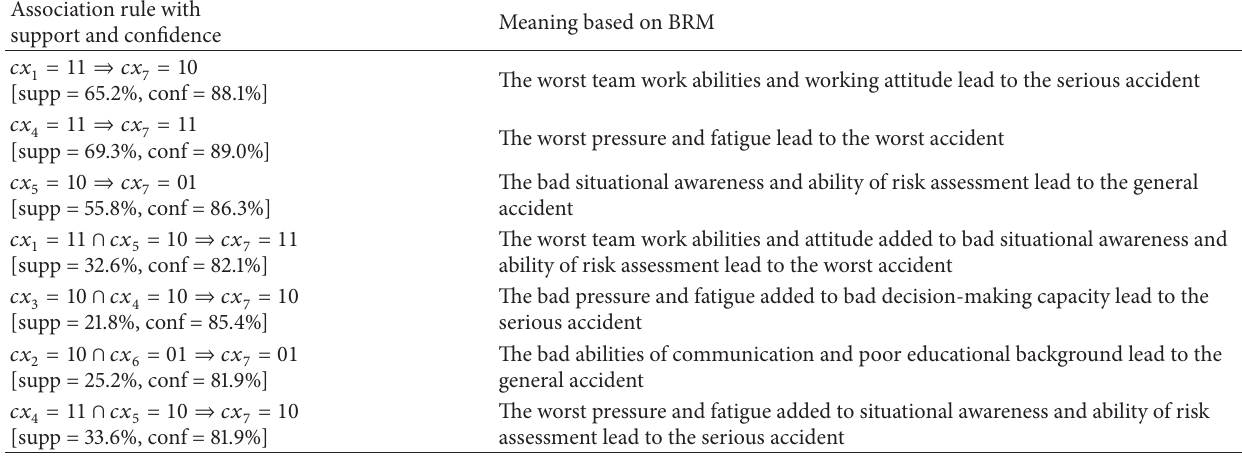
Table 6: Association rules and the meaning of them based on